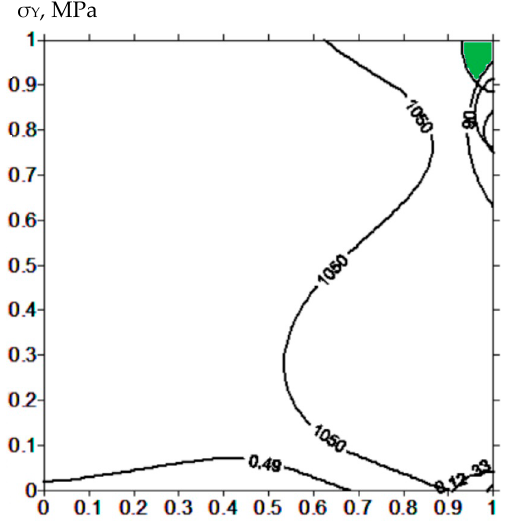
Figure 15. The range of the control parameters that ensure the physical and mechanical properties of the composites meet the specified limits for the “moderate” conditions of the metal-polymer tribological loading